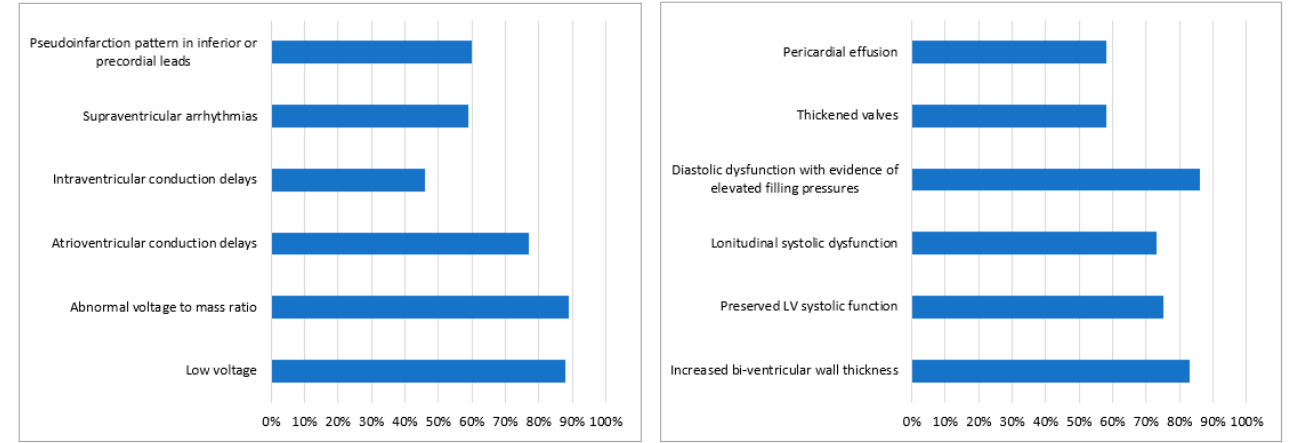
Figure 4. ( A ) Electrocardiographic hallmarks of cardiac amyloidosis chosen by the survey participants. ( B ) Echocardio- graphic hallmarks of cardiac amyloidosis chosen by the survey participants. LV—left ventricle.